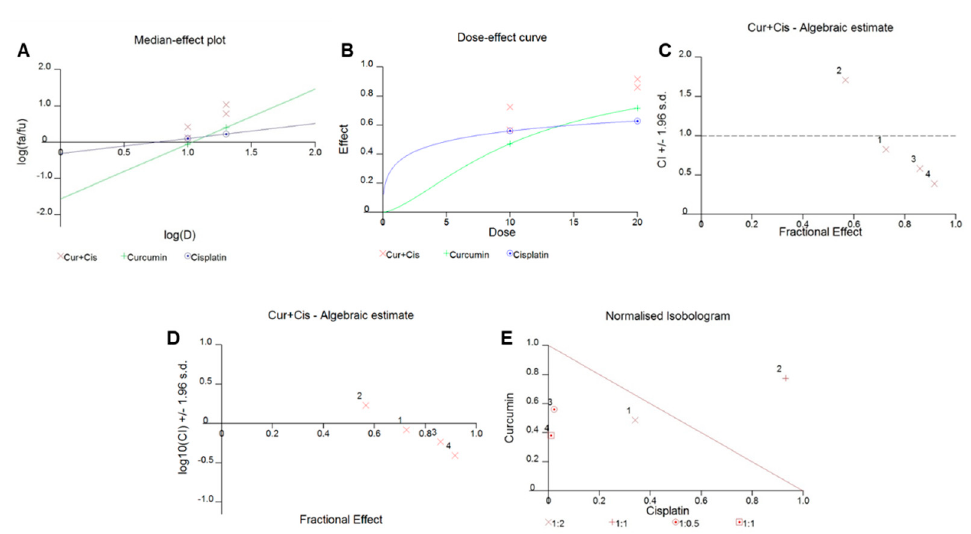
Figure 3. Curcumin synergistically enhanced the antiproliferative response of cisplatin in PTC cells. BCPAP cells were treated with various combinations of curcumin and cisplatin for 24 h, and graphs were generated using Calcusyn software, as described by Chou and Talalay. Briefly, curcumin and cisplatin were combined, and at least four di ff erent combinations were used to treat PTC cells for 24 h. A cell proliferation assay was performed using a CCK8 kit, as described in the materials and methods section, and data are expressed as the mean +/ − the SD of at least six replicates. Di ff erent types of graphs, using Calcusyn software (as described by Chou and Talalay), including ( A ) a median dose e ff ect graph, where the y axis represents the scale of fa (the fraction a ff ected by the dose) and fu (the fraction una ff ected by dose); ( B ) a graph representing the dose e ff ect curve of curcumin and cisplatin alone and in combination; ( C , D ) graphs representing the combination index (CI) value of the curcumin and cisplatin combination; and ( E ) a graph representing an isobologram of the curcumin and cisplatin interaction, were generated. CUR: curcumin; CIS: